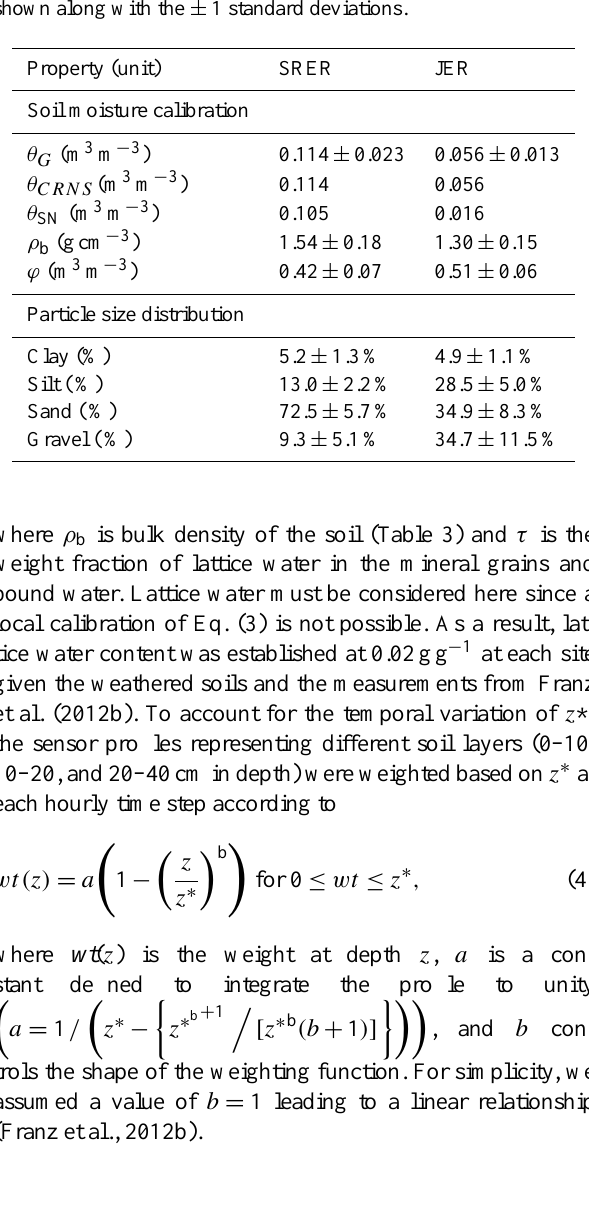
Table 3. Soil properties at SRER and JER. Soil moisture values cor- respond to conditions during the CRNS calibration dates (February 13, 2013 at SRER and February 10, 2013 at JER) for the gravimet- ric sampling at 18 locations with six depths ( θ G ), CRNS ( θ CRNS ), and the sensor network ( θ SN ), each expressed as volumetric soil moisture using the soil bulk density ( ρ b ) and soil porosity ( ϕ ) of the samples. Mean values of θ G , ρ b , and ϕ are shown along with the ± 1 standard deviations. Particle size distributions were obtained from soil auger sampling of the top 45cm at 20 locations at each site (An- derson, 2013). Mean values of percent clay, silt, sand, and gravel are shown along with the ± 1 standard